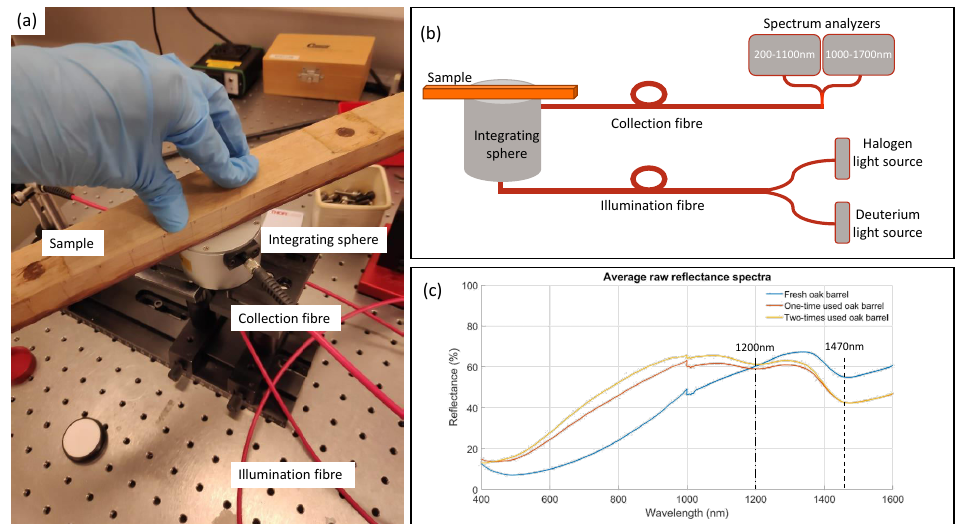
Figure 1. Measurement setup for reflectance spectroscopy. ( a ) Using a setup consisting of broadband light sources, optical fibres, an integrating sphere, and spectrum analyzer, the reflectance spectrum of the oak samples can be accurately measured. ( b ) Schematic overview of the experimental setup. ( c ) Raw reflectance spectra of three oakwood samples. A jump in spectra at 1000 nm is due to the stitching of two spectrum analyzers. The peaks at 1200 nm and 1470 nm indicate the characteristic bonds for cellulose, water, and